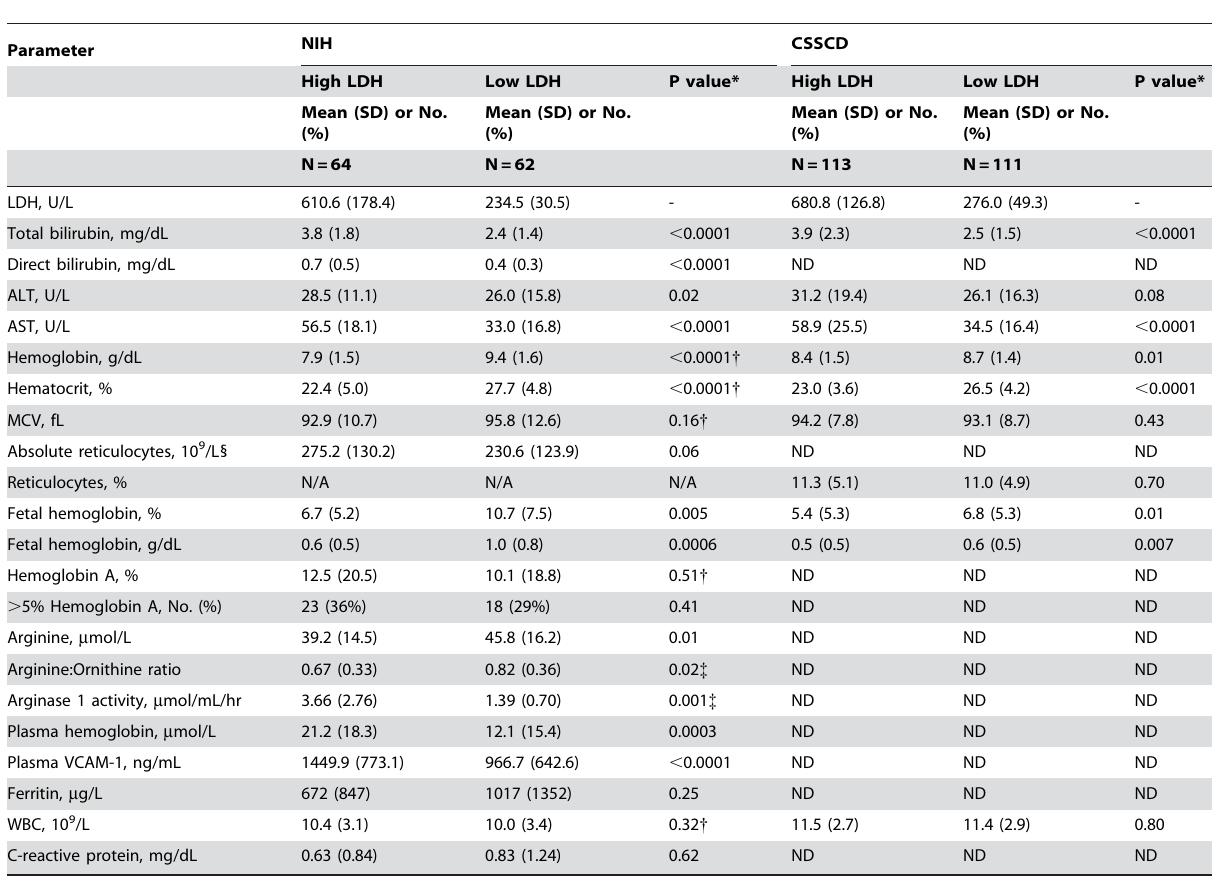
Table 1. Laboratory Characterization of the High and Low Hemolysis Phenotypes of Sickle Cell